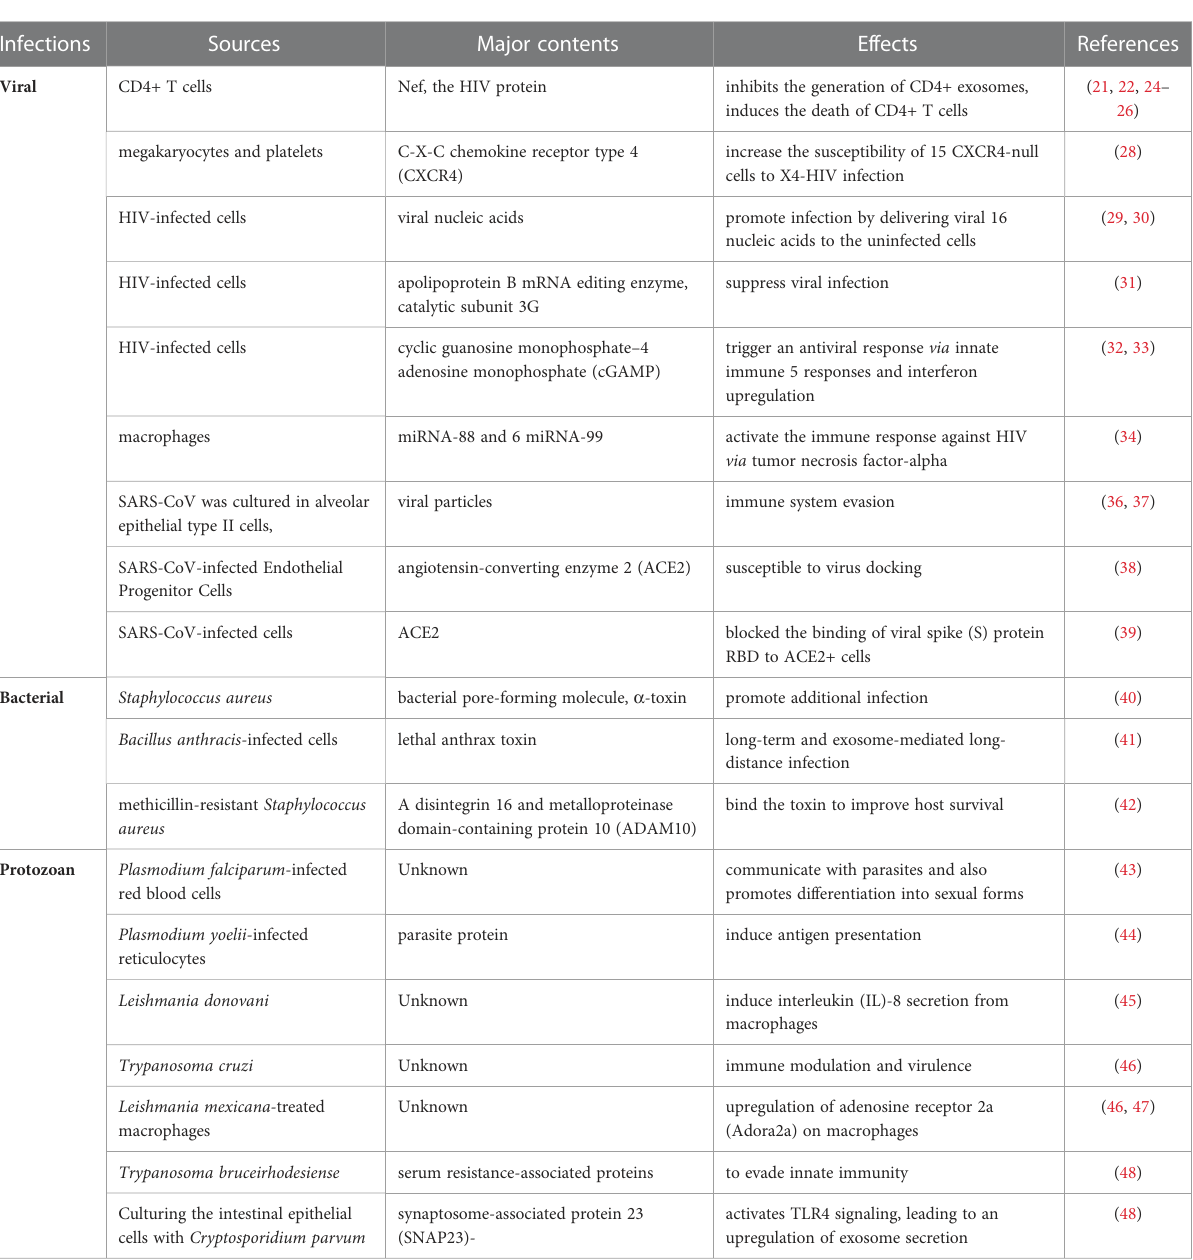
TABLE 1 Exosomes in pathogen